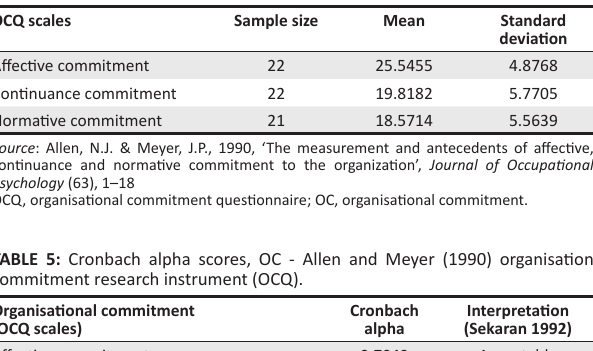
TABLE 4: Summary statistics, OC - Allen and Meyer (1990) OCQ.